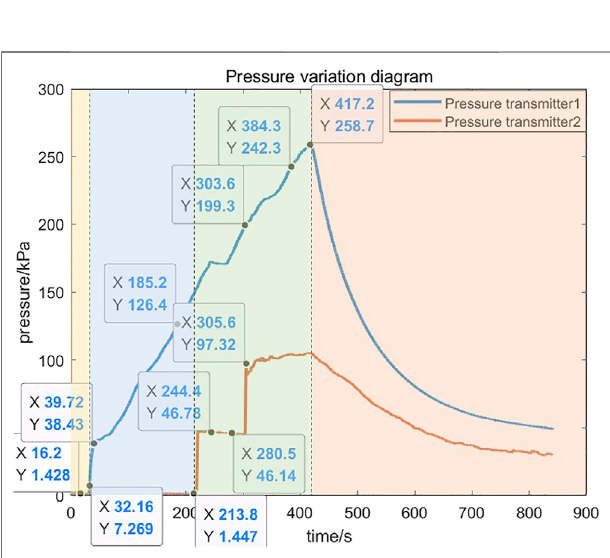
FIGURE 5 | Smoothed acoustic emission signal segmentation in the experiment.